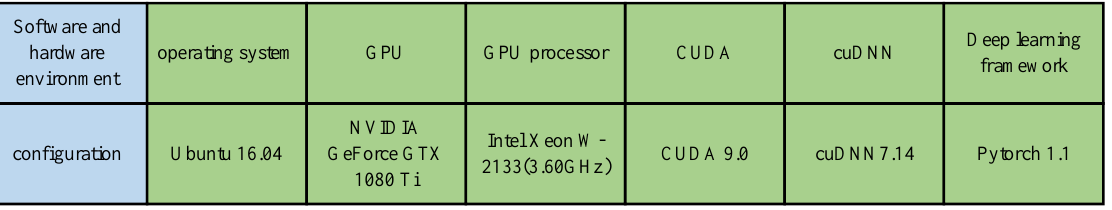
Figure 11. The experimental configurations.